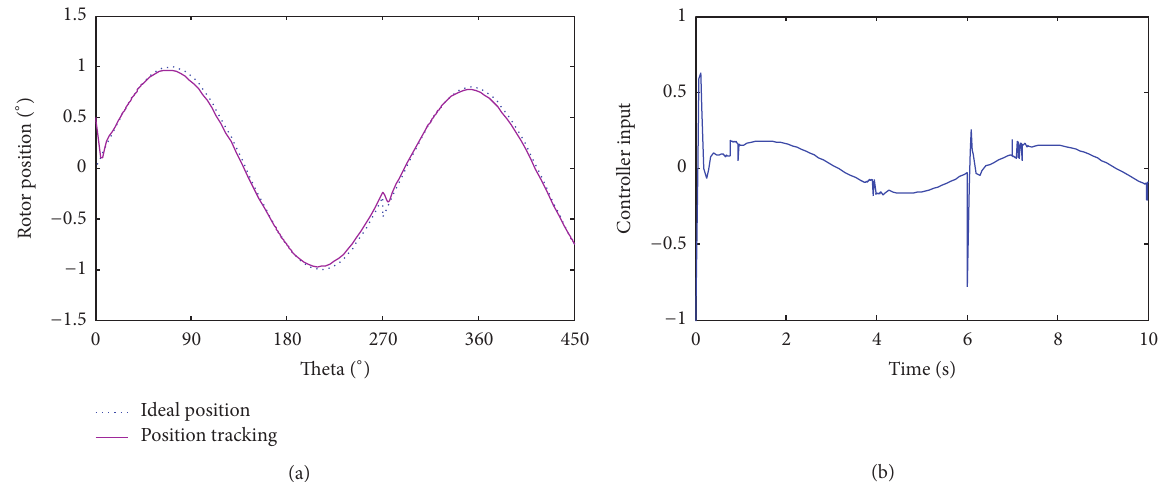
Figure 11: Simulation results of the backstepping SMC when the interference is applied. (a) Position tracking. (b) Control input.